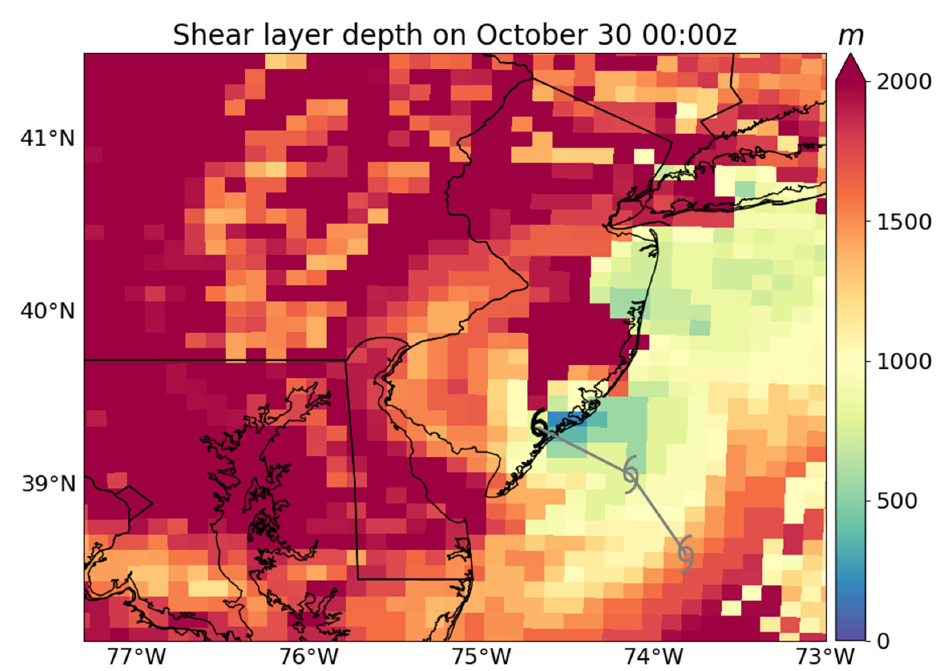
Figure 10. The radial wind shear layer depth (SLD) as simulated in WRF at 0000 UTC 30 October